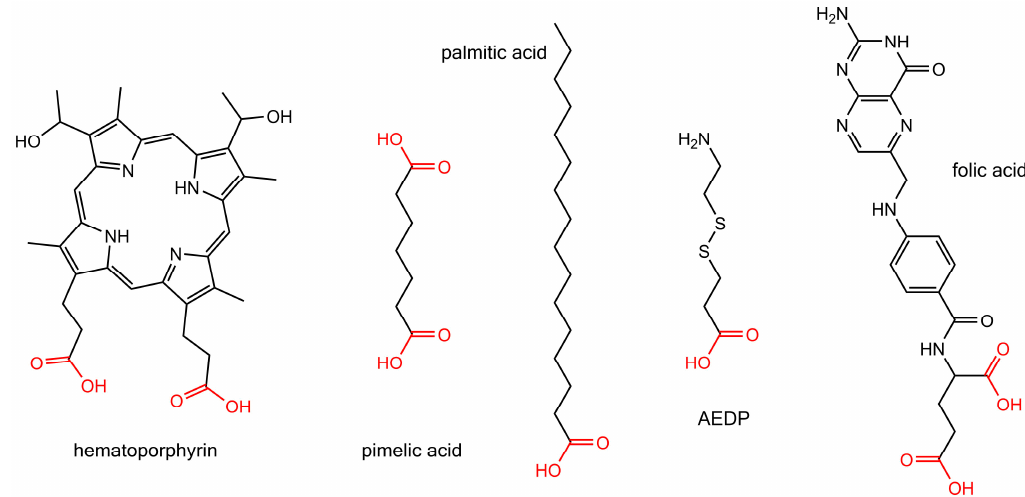
Figure 5. Molecules for Ni nanorod surface modification based on carboxyl groups. The carboxyl groups are shown in red. From left to right these molecules are: hematoporphyrin, pimelic acid, palmitic acid, 3-[(2-aminoethyl)dithio] propionic acid (AEDP), and folic acid.